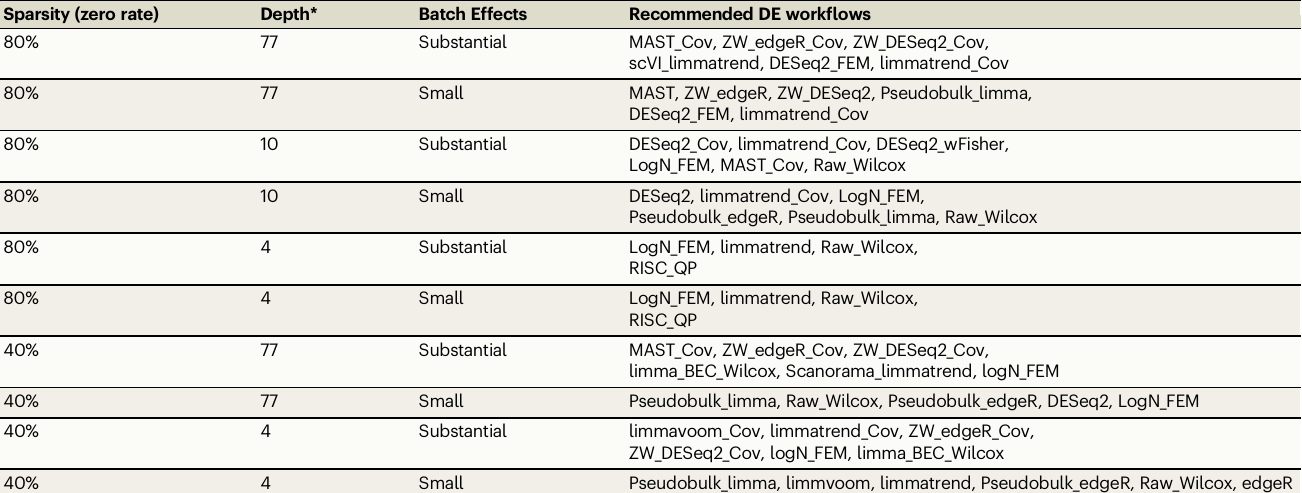
Table 1 | Recommended differential expression (DE) work fl ows for different experimental conditions Sparsity (zero